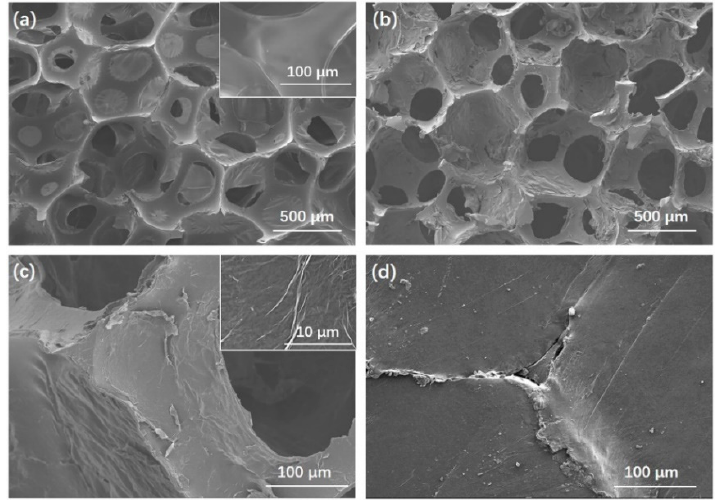
Figure 2. Scanning electron microscope (SEM) images of PU foam ( a ); rGOF ( b , c ) with different resolutions; the cutting edge of the rGOF/SPU composite ( d ).